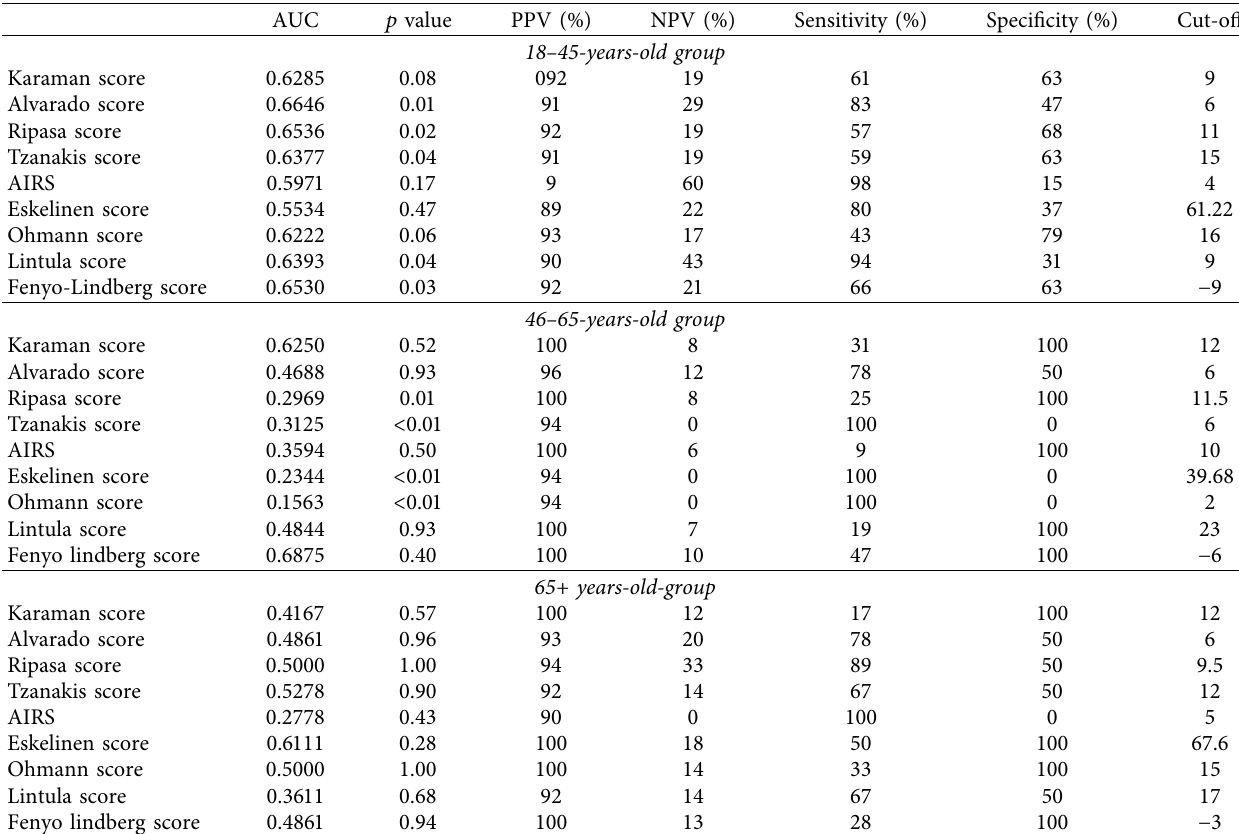
Table 4: ROC curve